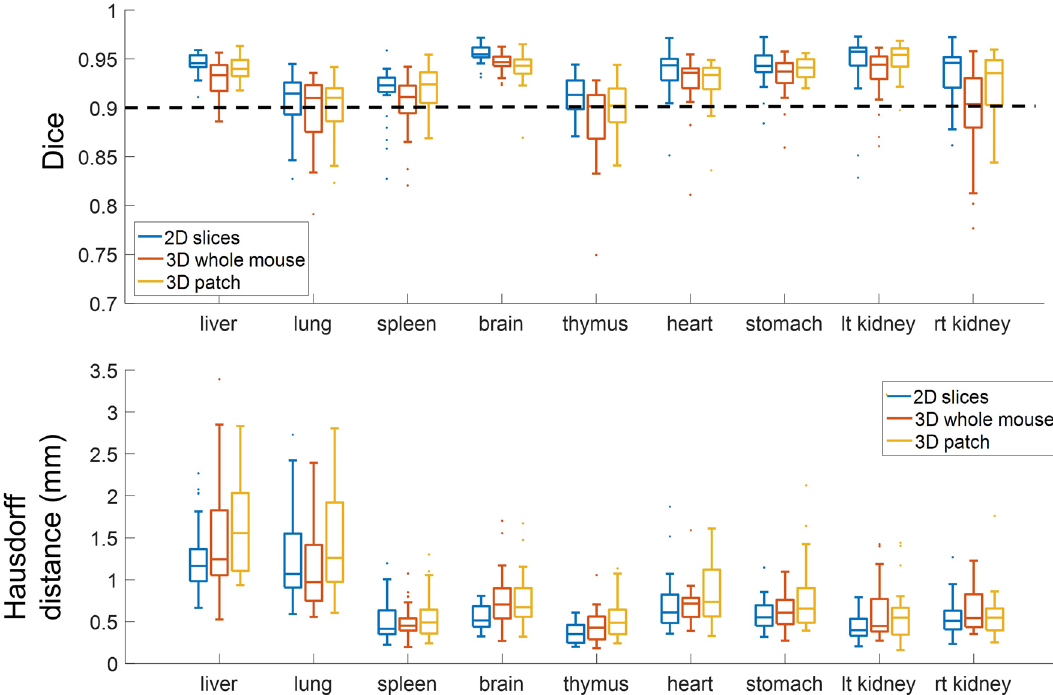
Figure 6. Comparison of the three models for an eightfold cross validation across organs. Dice scores (top) and Hausdorff distances (bottom) are shown. 2D-slices had best median Dice score and Hausdorff distance across a majority of organs, and was significantly different from the other two models.